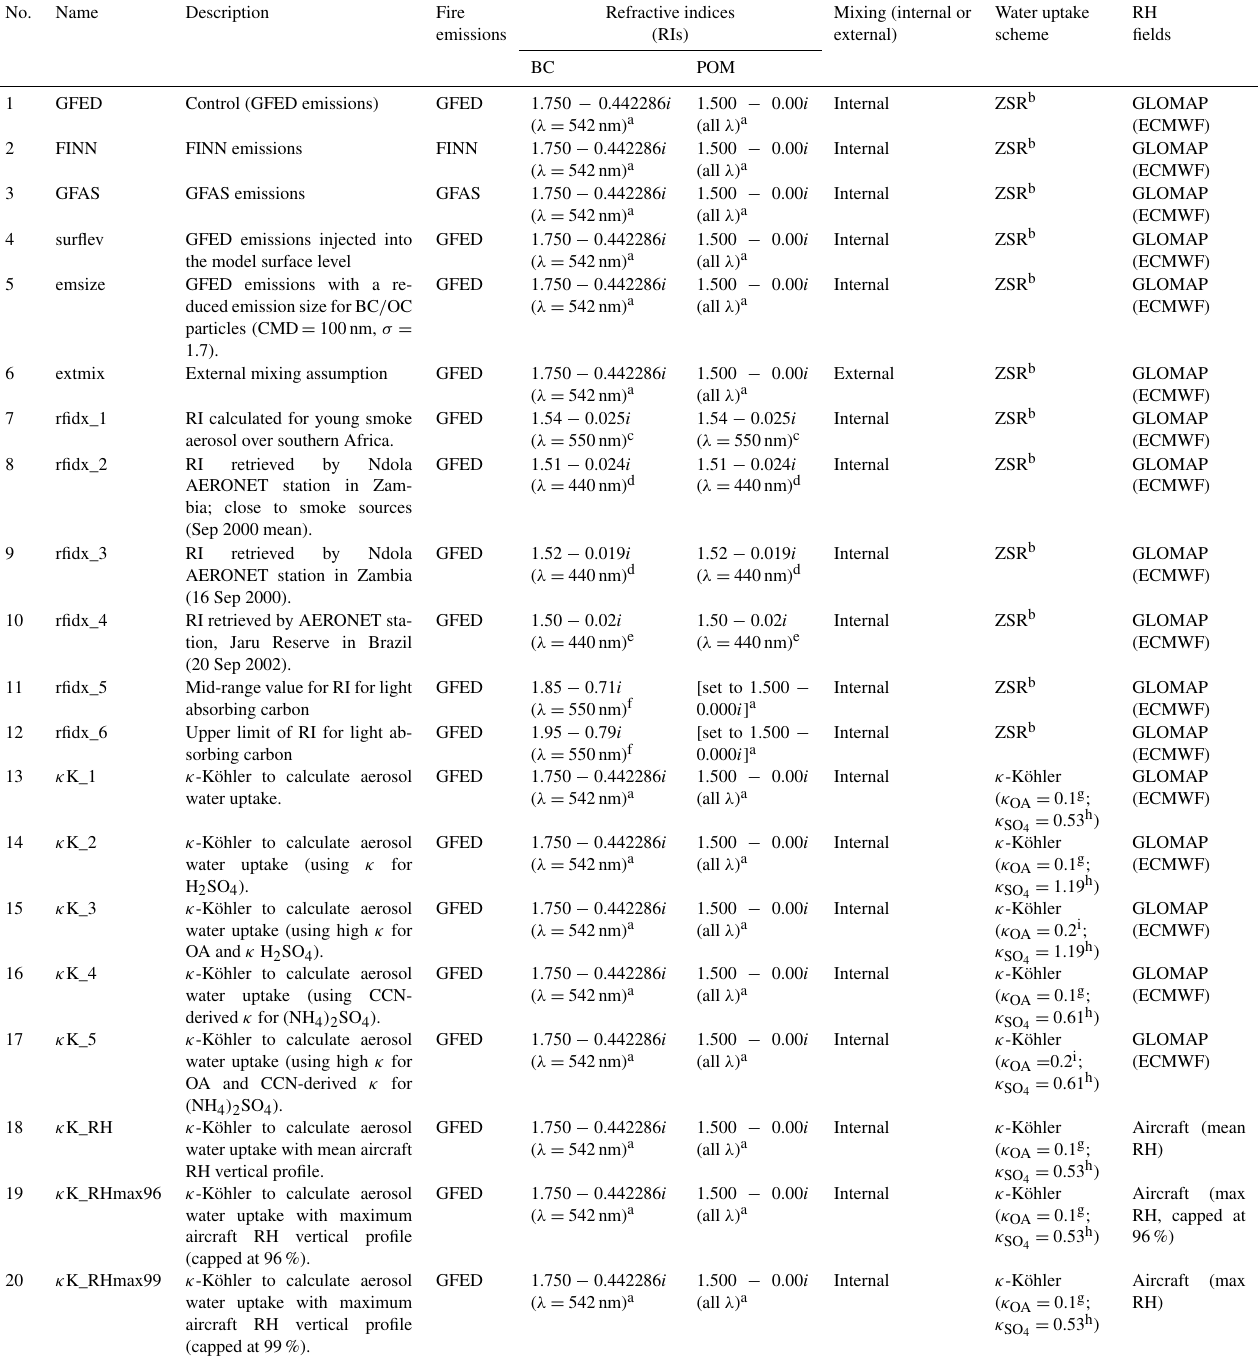
Table 3. Summary of tests performed to explore the sensitivity of simulated aerosol optical depth (AOD) to assumptions about biomass burning emissions, aerosol optical properties (refractive indices, RIs), aerosol mixing state and aerosol water uptake calculation (Sect. 3.5). The water uptake schemes used (ZSR and κ -Köhler) are described in Sect. S1 ( κ is the component-specific hygroscopicity